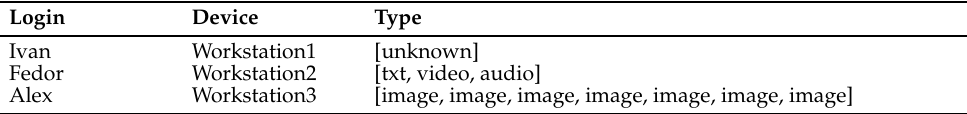
Table 10. Example of query results of the algorithm for Feature